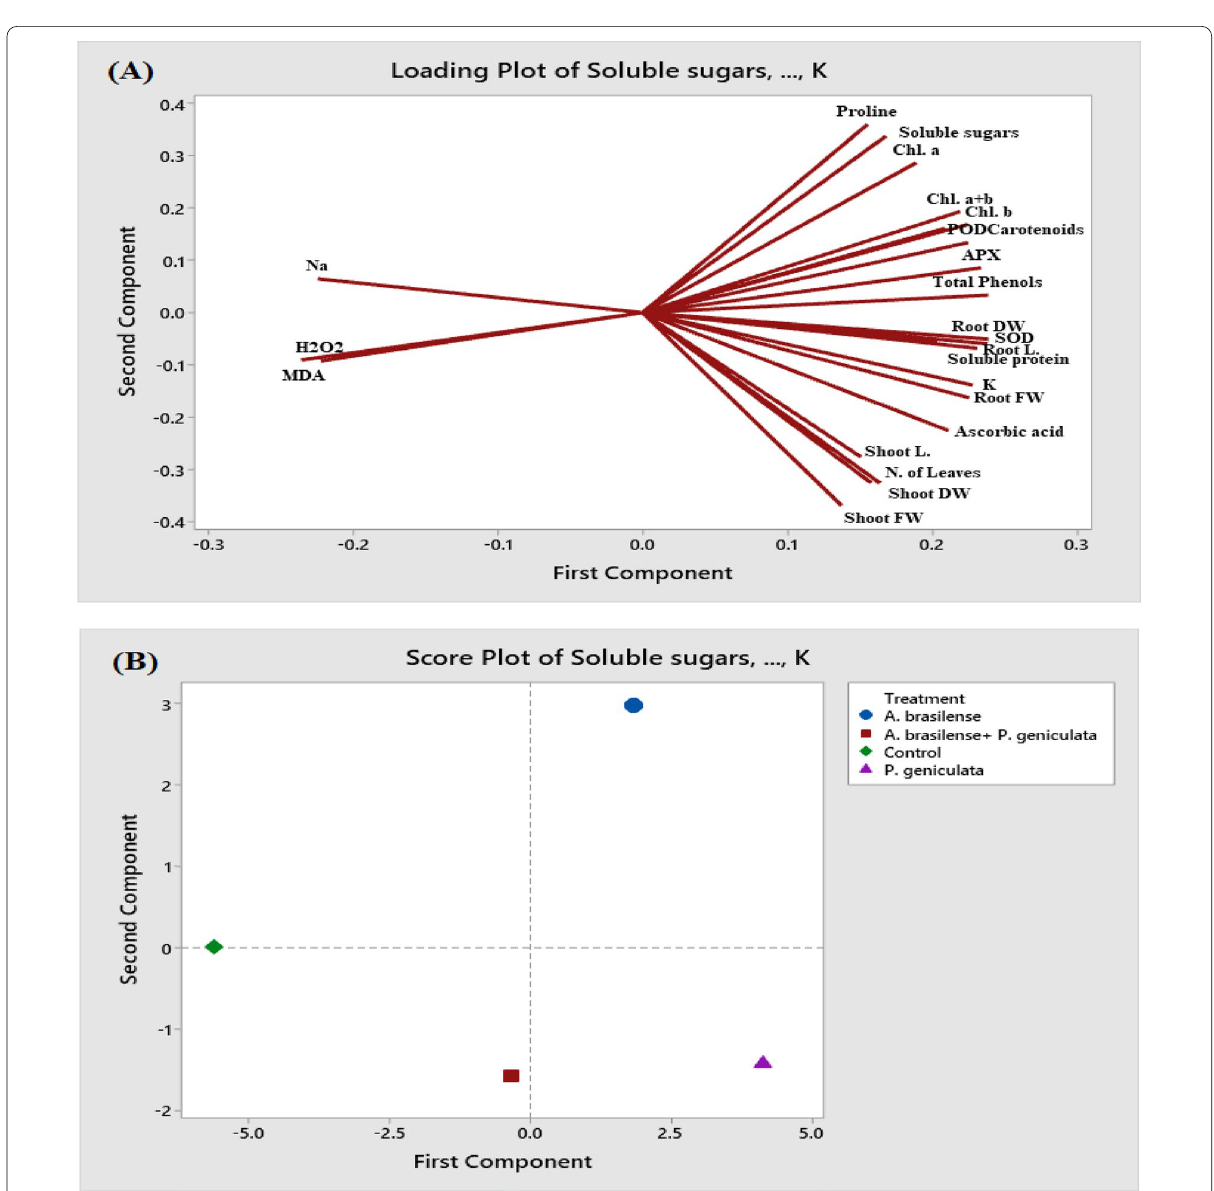
Fig. 6 A Principal component analysis (PCA) to understand the variability relationships of parameters and treatments in flax plants. The entire dataset was analyzed using a PCA clustering approach. The parameters included Shoot L. (Shoot length), Root L. (Root length), Shoot FW (fresh weight of shoot), Shoot DW (Shoot dry weight), Root FW (fresh weight of root), Root DW (Root dry weight), number of leaves, Chl. a (chlorophyll a ), Chl. b (chlorophyll b ), (carotenoids), soluble sugars, soluble protein, proline, K (potassium), Na (sodium) MDA (malondialdehyde), H 2 O 2 (Hydrogen peroxide), SOD (superoxide dismutase), APX (ascorbate peroxidase), and POD (peroxidase). ( B ) The treatments of the flax plants were shown in different shapes with different colors under salinity stress conditions. The 1st was flax plants grown in saline soil and represented as green rhombus (Saline soil control). The 2nd was flax plants inoculated with both bacterial strains Azospirillum brasilense and Pseudomonas geniculata and represented as a red square. The 3rd was flax plants inoculated with Azospirillum brasilense and represented as a blue circle. The 4th was plants inoculated with Pseudomonas geniculata and represented as a purple